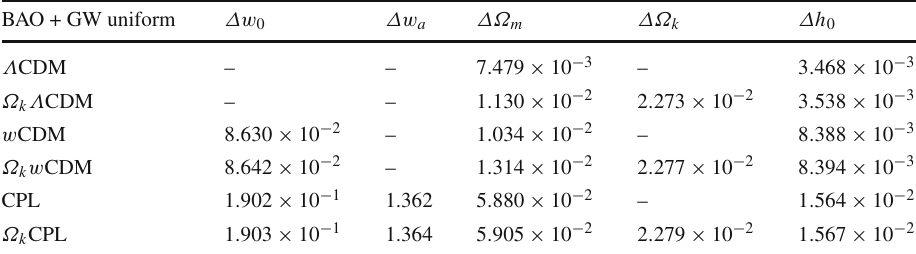
on cosmological parameters from the combination of DESI BAOs and ET GWs for the nonuniform distribution of GW sources